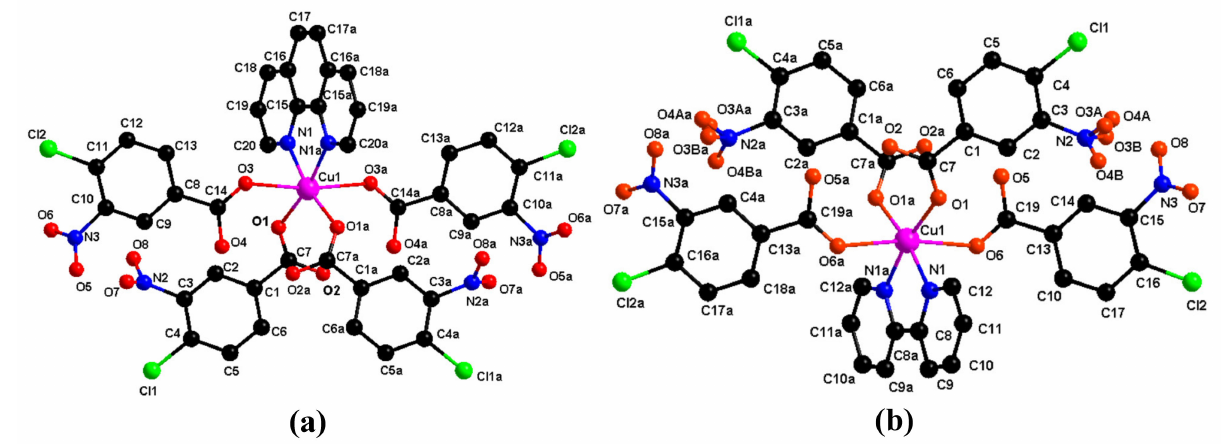
Figure 1. Crystalline structures of Cu(II) complex 1 ( a ) and Cu(II) complex 2 ( b